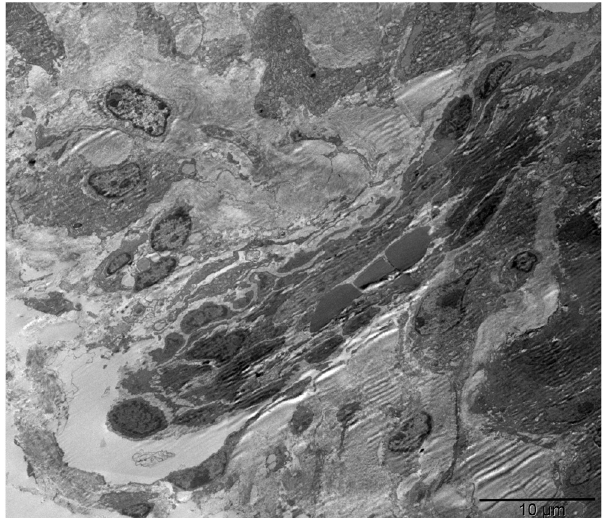
migrate long distances and deal with the forms that are no longer useful. The requirement for continuous regulation to maintain a differentiated phenotype was postulated previously 70 . A network of arrows pointing in different directions, including reverse, would represent the actual cellular differentiation pathways better than the traditional tree. “A good analogy likens cell types to metabolites in metabolic networks” 40 .